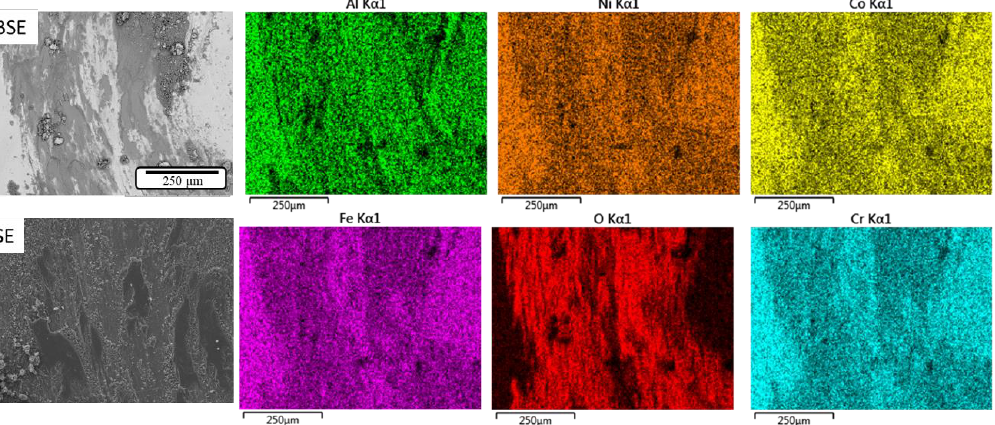
Figure 6. BSE and SE images and corresponding EDS elemental maps of the A1 alloy wear track after 300 °C sliding.